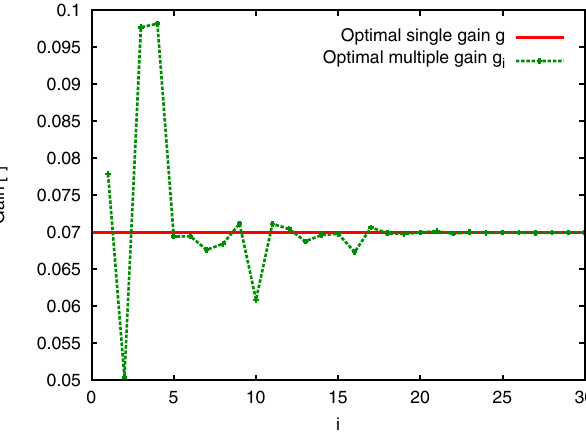
FIG. 22. (Color) Minimum achievable multipulse emittance growth rate for different numbers of BPM patterns. The 25–30 most important patterns have to be considered to achieve optimal performance. The figure also shows how well the trajectory can be controlled with information from a limited number of BPM patterns.